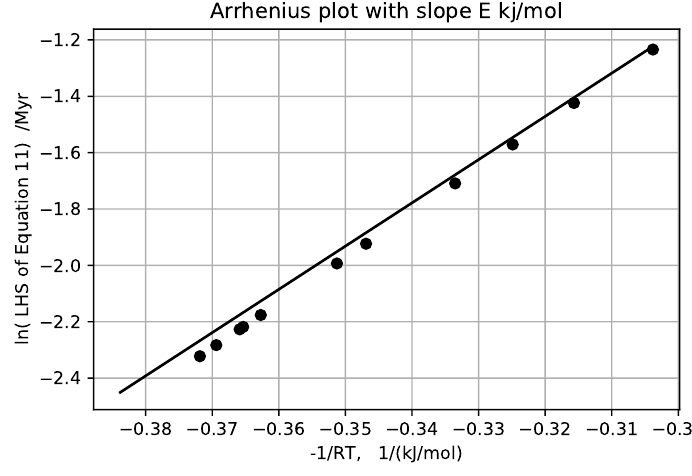
Figure 21. Makran2 −